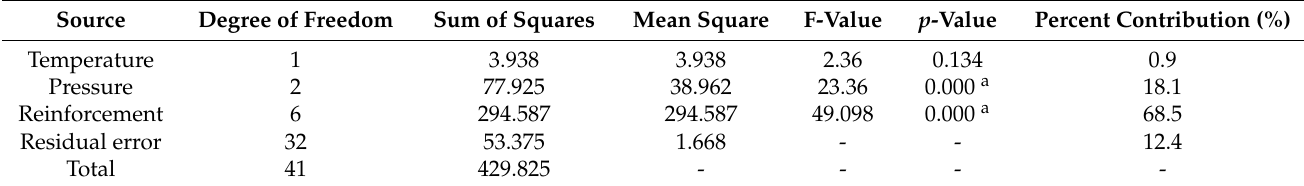
Table 5. Analysis of variance for S/N ratios of surface roughness (Rz).